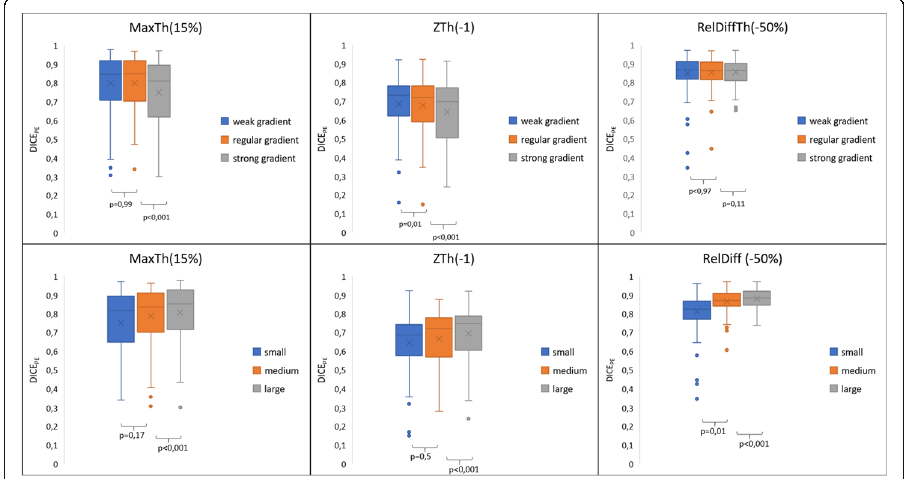
Fig. 4 Influences of intensity gradient strenght (first row) and lung volumes (second row) on Dice PE coefficients according to the segmentation methods. Using the RelDiff method with a − 50%